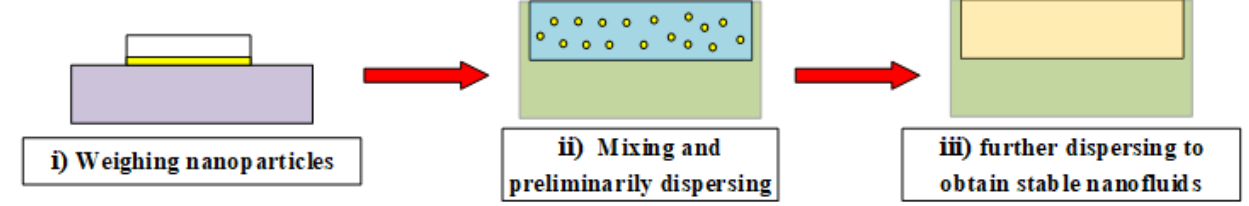
Figure 3. Two-step method for preparing